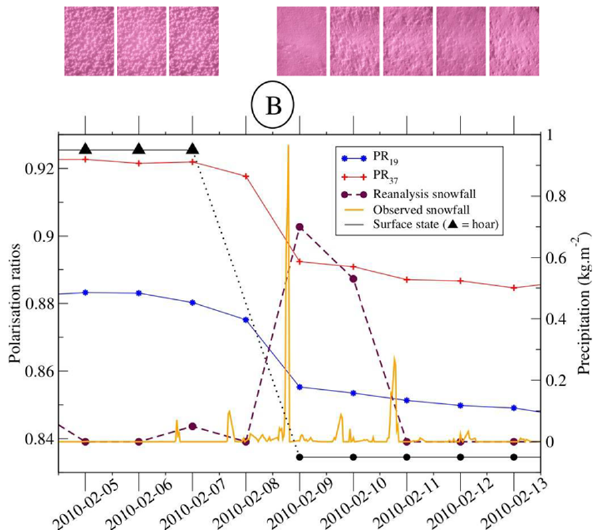
Fig. 13. Observed and forecasted snowfall on 9 February 2010 at Dome C, during the disappearance of hoar crystals (unscaled black symbols and small pictures above the graph) present on the snow surface (event B in Fig. 7). Between the 8 and 9, a decrease of po- larisation ratios at 19 and 37GHz is also observed.